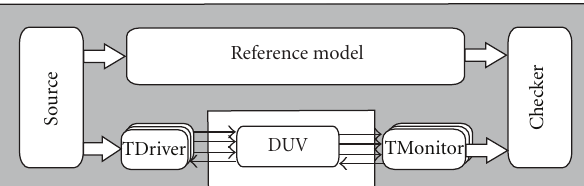
Figure 8: Testbench